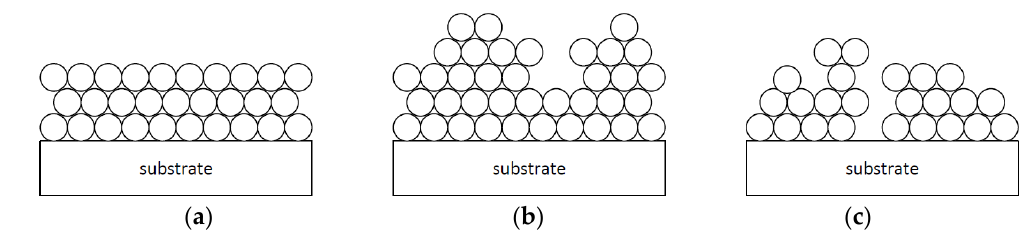
Figure 2. Models for layer growth: Frank van der Merwe (a); Stranski ‐ Krastanov (b); Volmer ‐ Weber (c) (adapted from [1,15]).